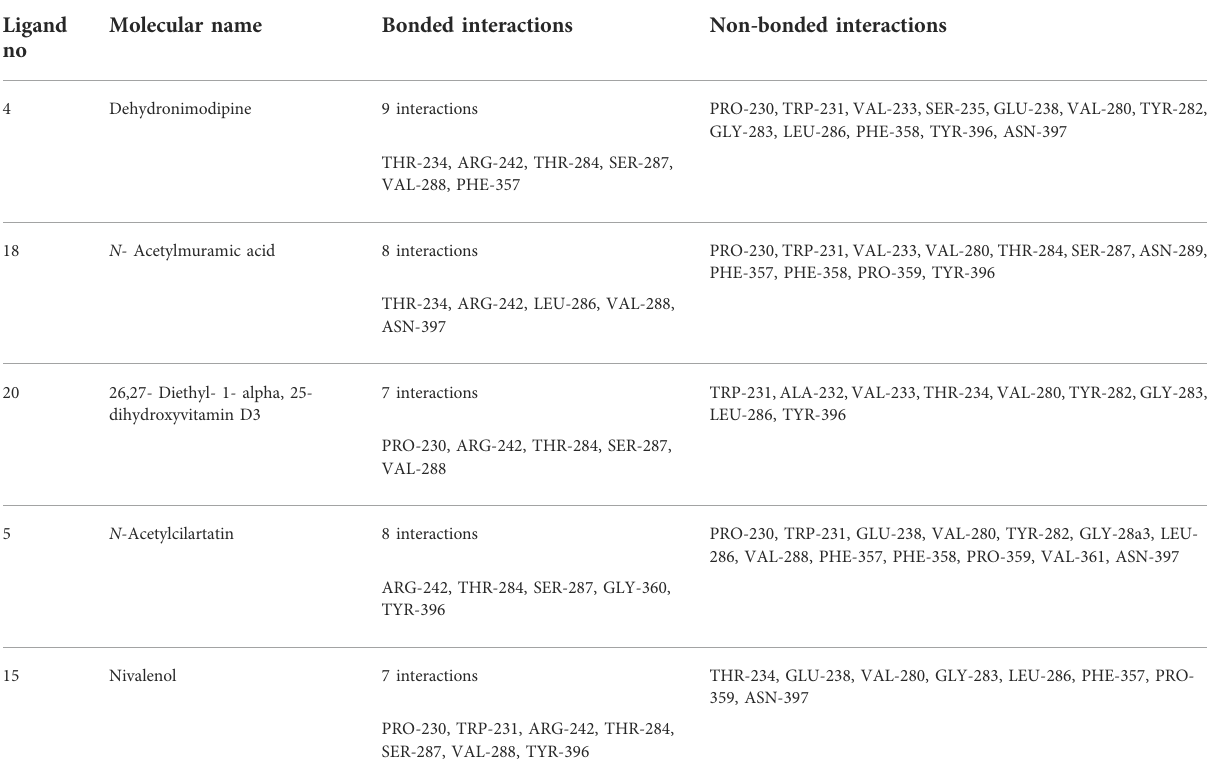
TABLE 2 Molecular docking binding energy and interactions of fi ve ligands against